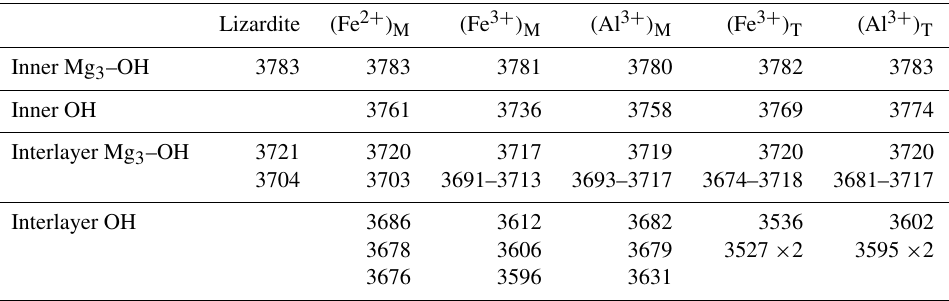
Table 2. Theoretical transverse optical (TO) OH stretching frequencies (cm − 1 ) in pure and Al- and Fe-bearing lizardite. The frequencies reported for Mg 3 OH in the substituted models correspond to the main band associated with an in-phase motion of the OH groups and to IR- active modes displaying out-of-phase displacement patterns. Depending on the system, the intensity of the latter can be spread over several modes in the specified frequency